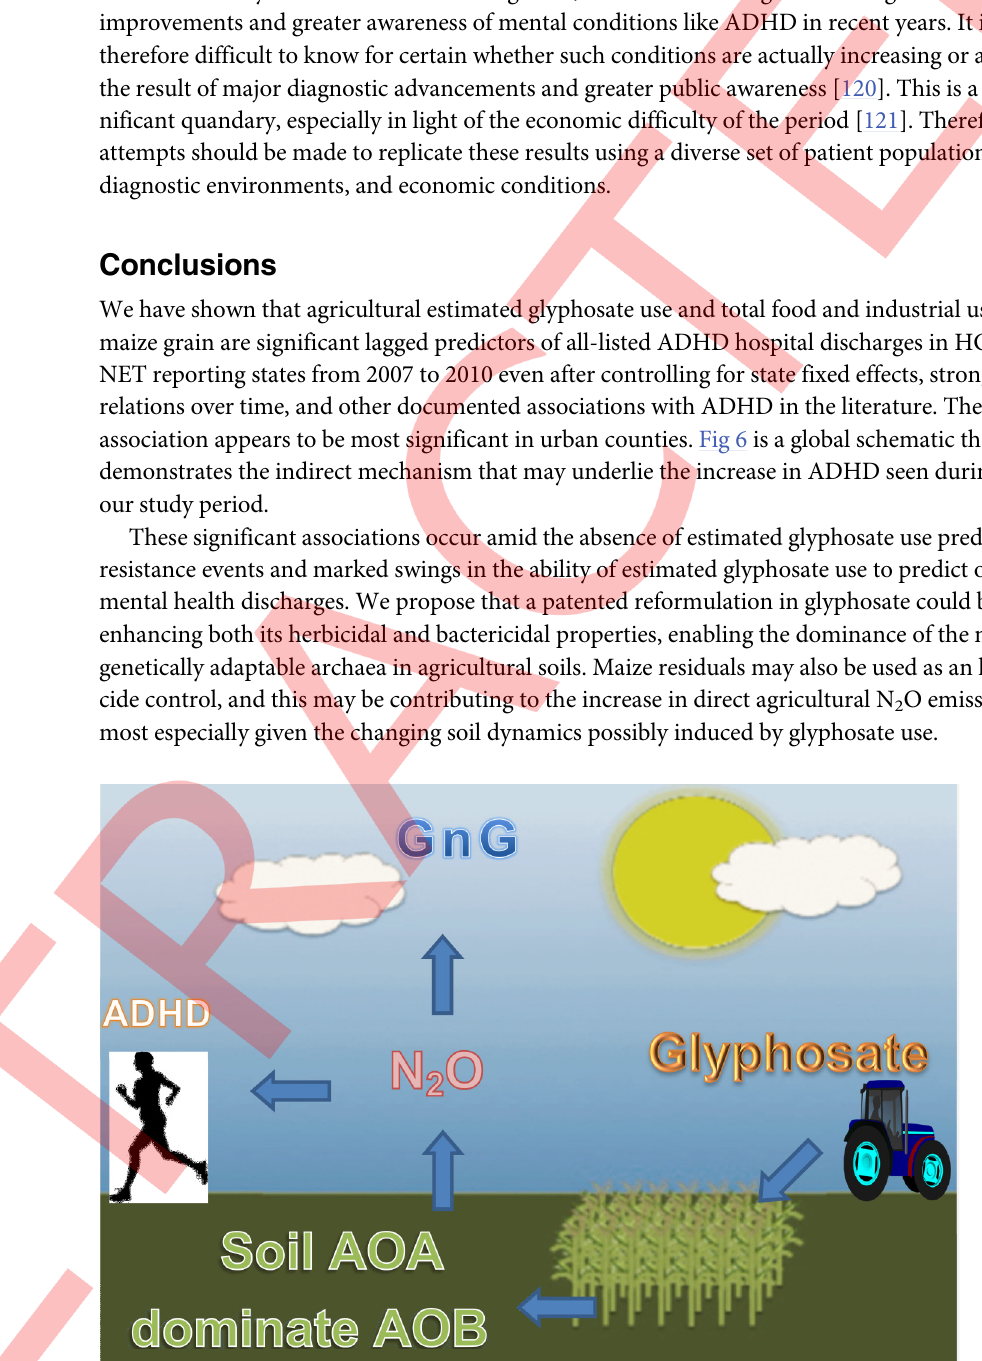
Fig 6. A global schematic proposing an indirect mechanism for how glyphosate-based herbicides may be contributing to the rise of ADHD during the period, 2007 to 2010. Abbreviations: N 2 O – nitrous oxide; GnG – greenhouse gassing; AOB – ammonia-oxidizing bacteria; AOA – ammonia-oxidizing archaea; ADHD – attention-deficit hyperactivity